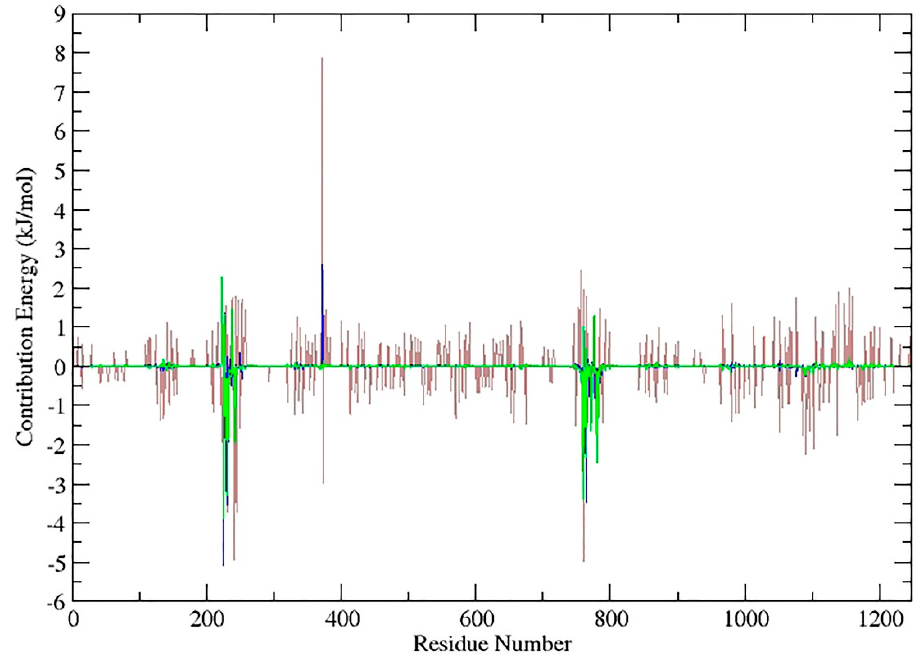
Figure 10. An overlay graph of contribution energy per residue to the binding energy (kJ / moL) for the three caryophyllane sesquiterpenes. Brown line represents contribution energy of α -caryophyllene, blue line represents β -caryophyllene and green line denotes β -caryophyllene oxide.